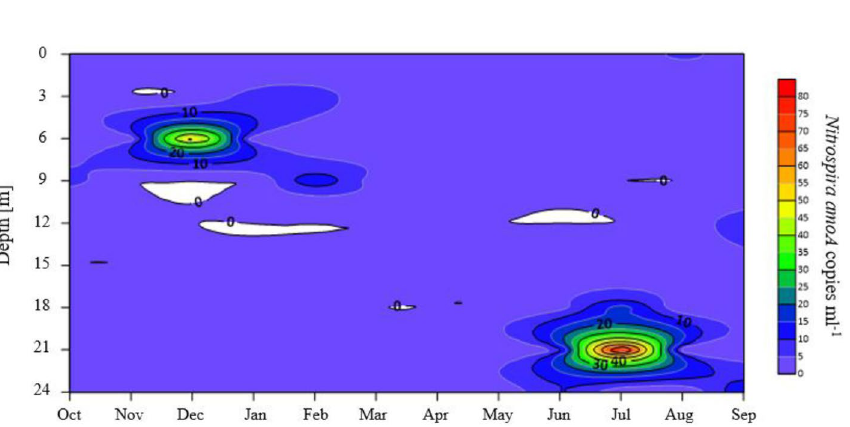
Figure 3. Spatiotemporal dynamics of Nitrospira amoA gene copy numbers in Piburger See. Samples were taken monthly with a vertical distance of 3